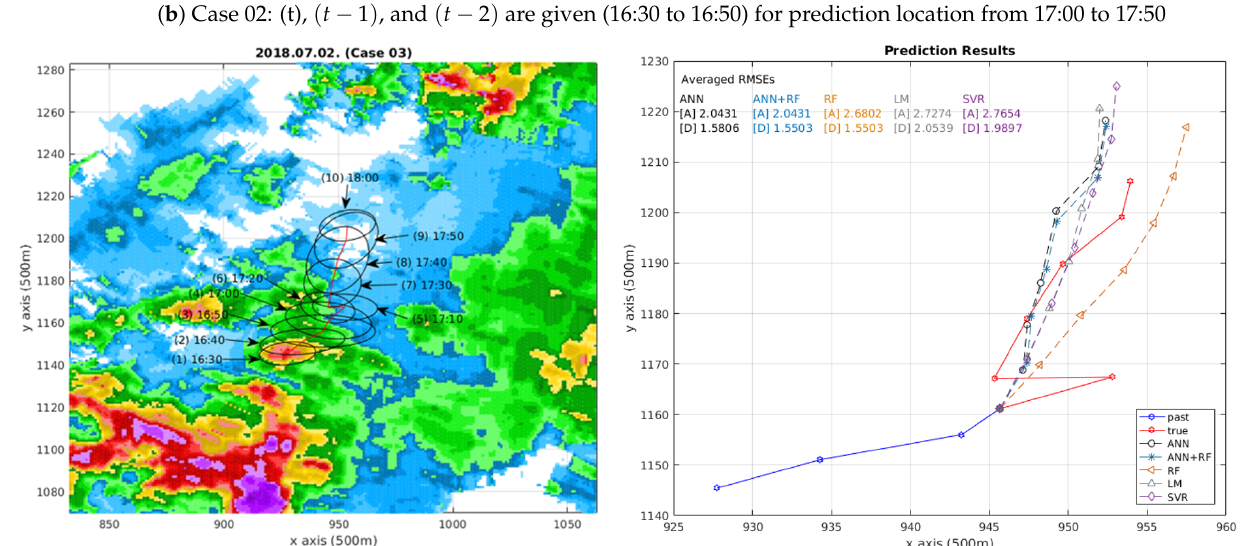
Figure 7. Observed trajectories and prediction results: ( a ) Case 01, ( b ) Case 02, ( c ) Case